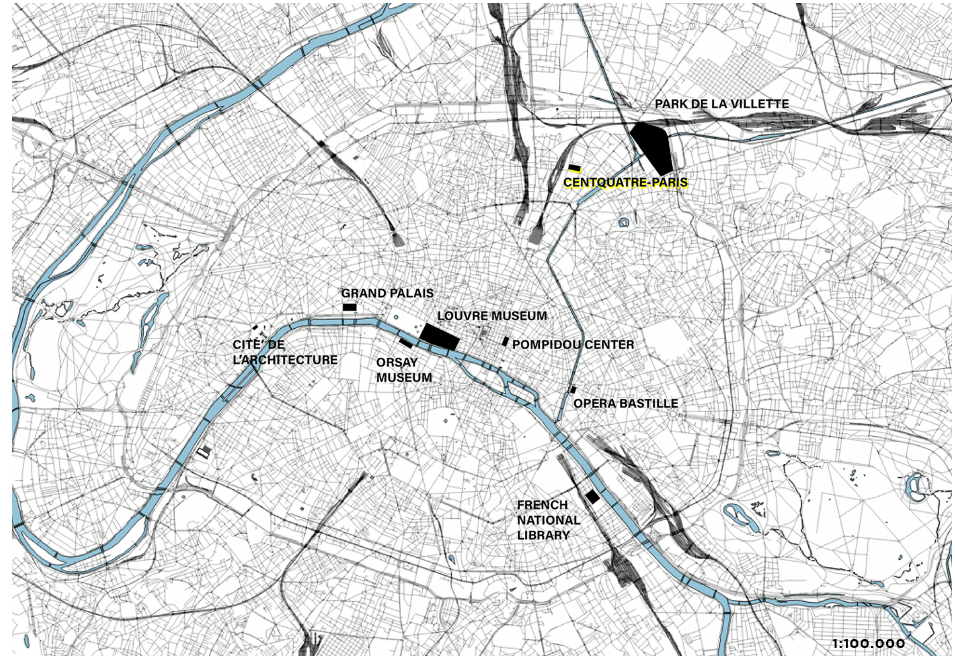
Figure 1. Map of the main public artistic and cultural centers in the city of